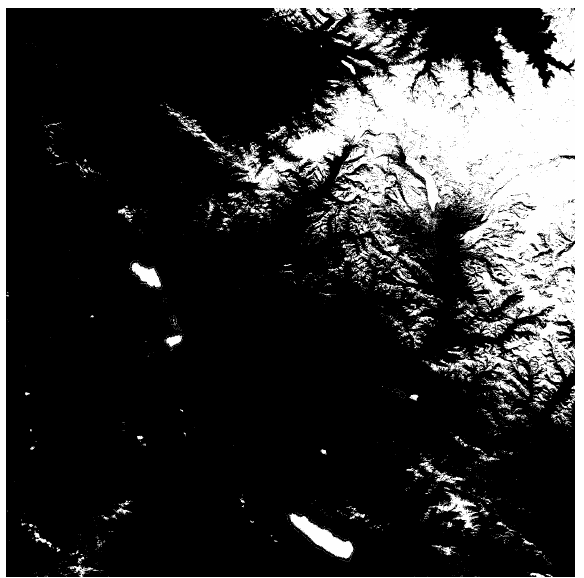
Figure 5. Ausangate Glacier clustering outcome with EM algorithm.